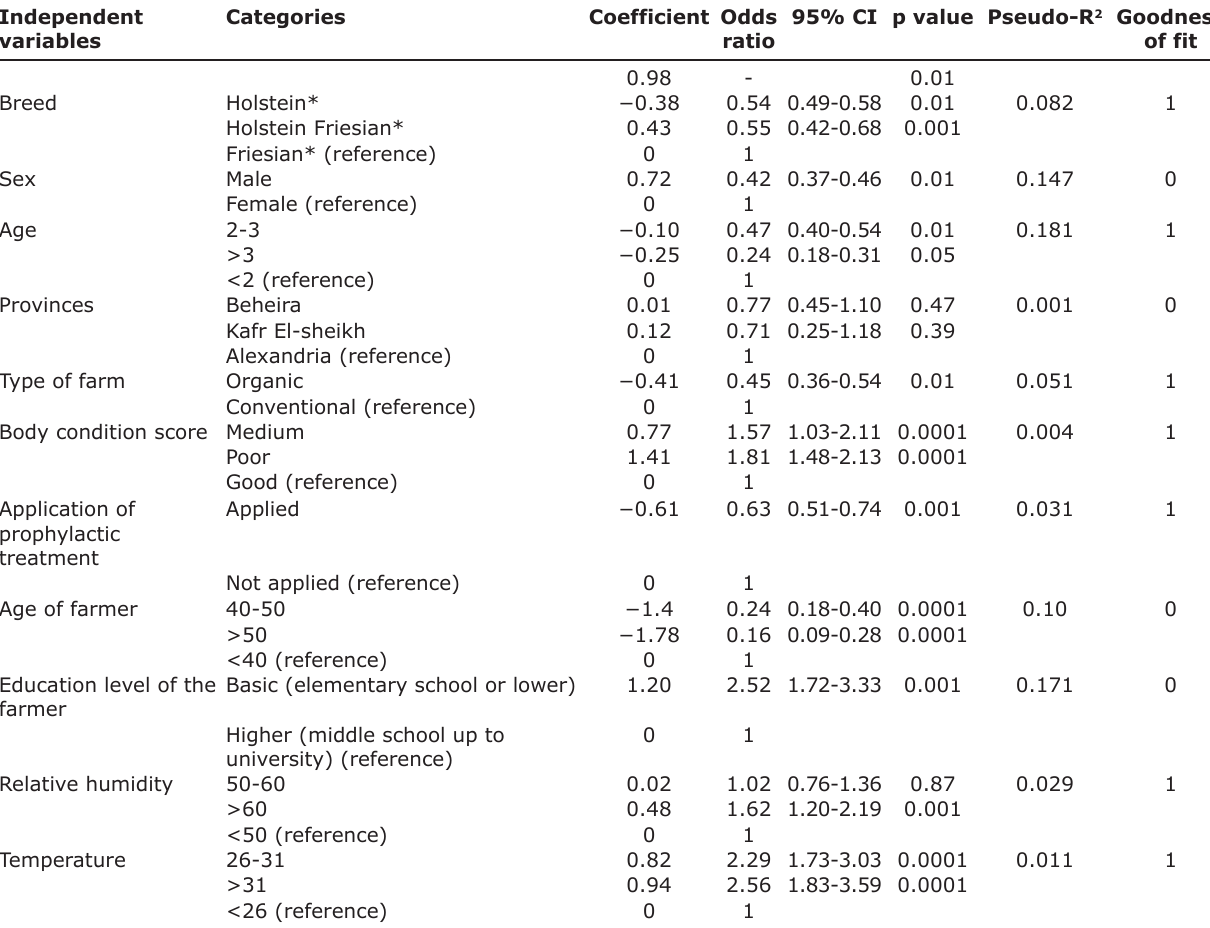
Table-4: Results of univariable logistic regression analysis between the potential risk factors and the prevalence of bovine fascioliasis in the Nile Delta region of Egypt. Independent